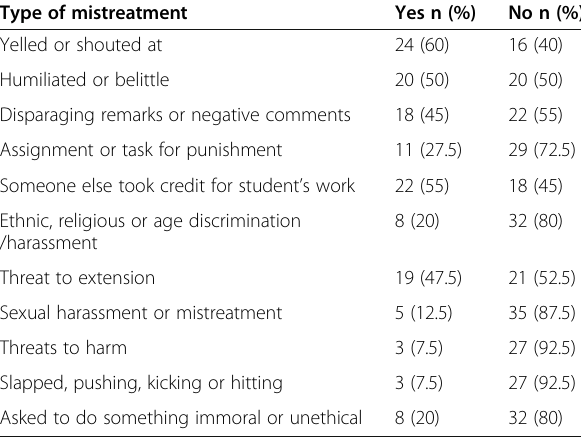
Table 2 Type of mistreatment the participants Type of mistreatment